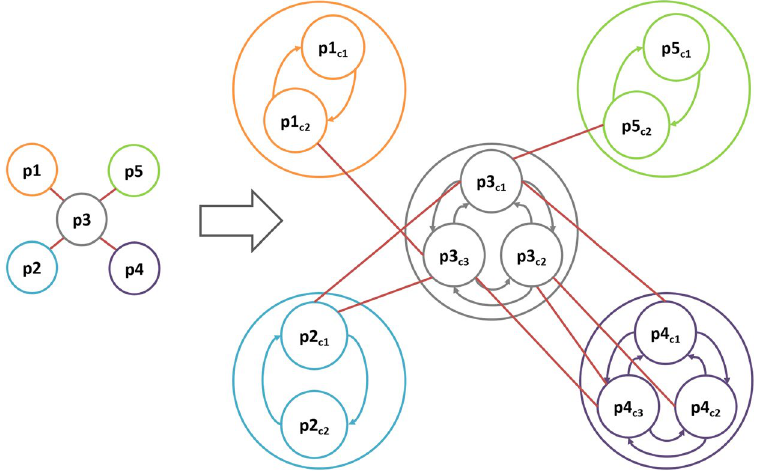
Figure 2. Structural PPI network in traditional representation on the left, and the new representation investigating proteins conformational changes on the right. Arrows show inter-conversions between alternative conformations of the same